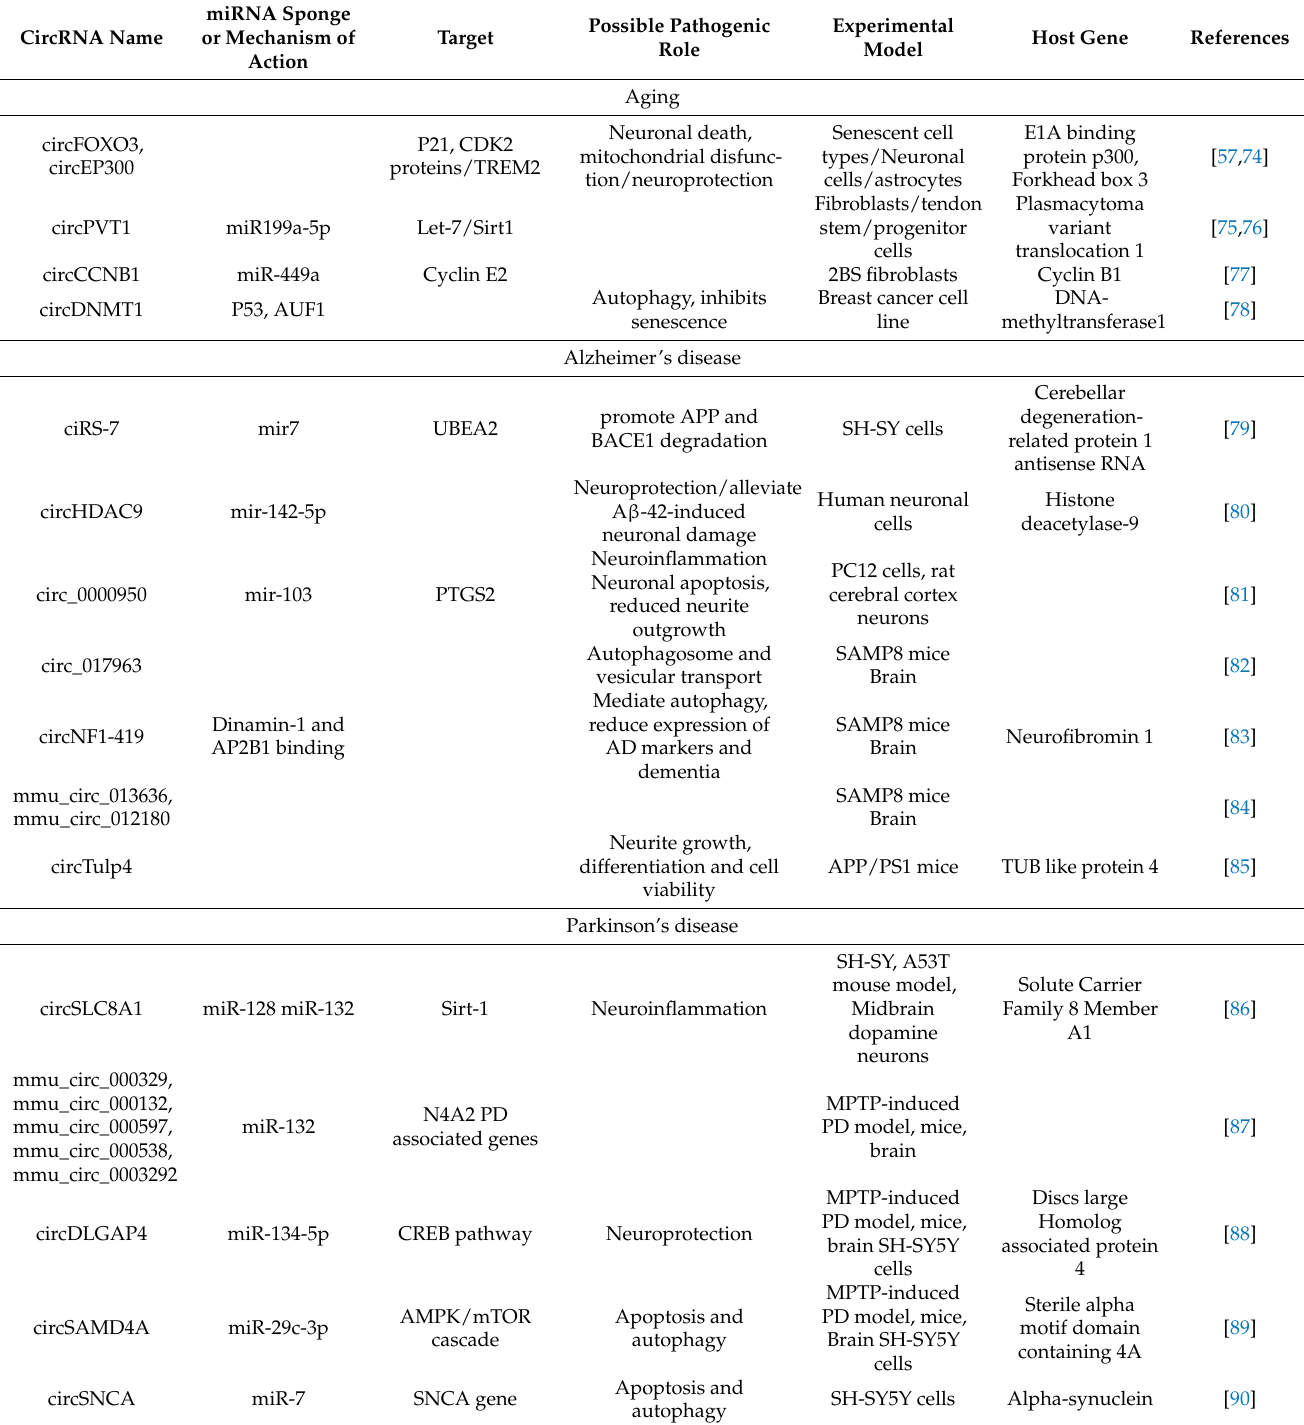
Table 2. circRNAs in aging, Alzheimer’s disease, Frontotemporal Dementia, and Parkinson’s disease experimental